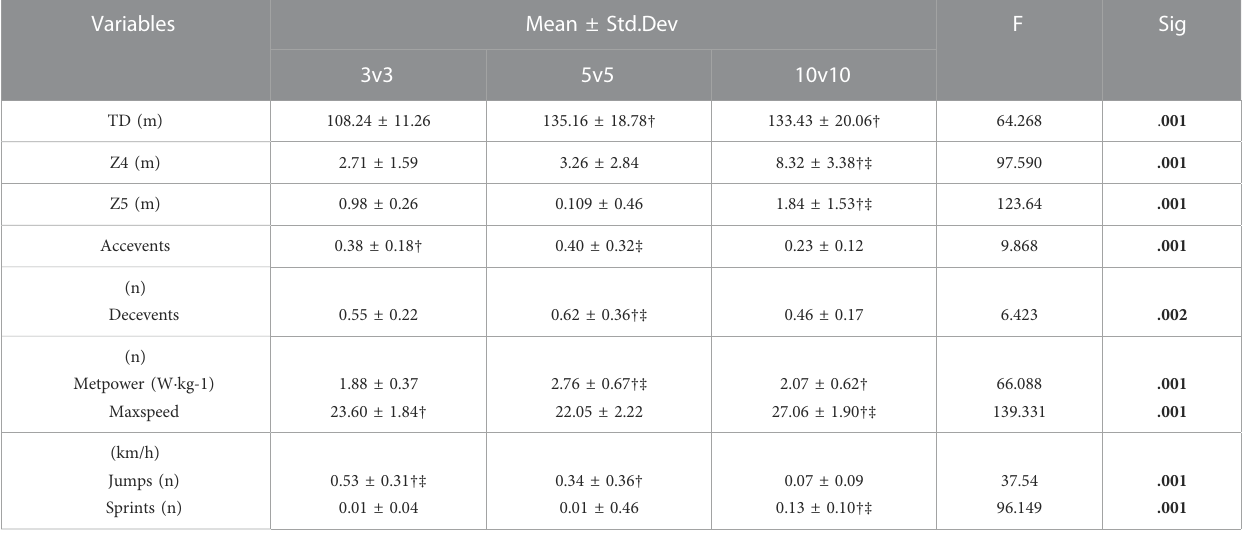
TABLE 3 Differences in kinematic parameters and metabolic power.